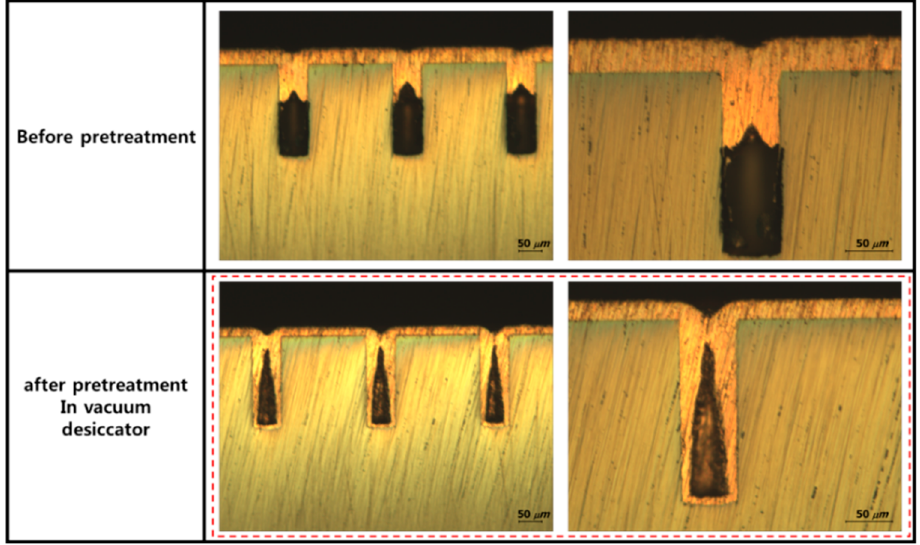
Figure 3. The cross-sectional optical microscope (OM) image before and after pretreatment in vacuum desiccator.